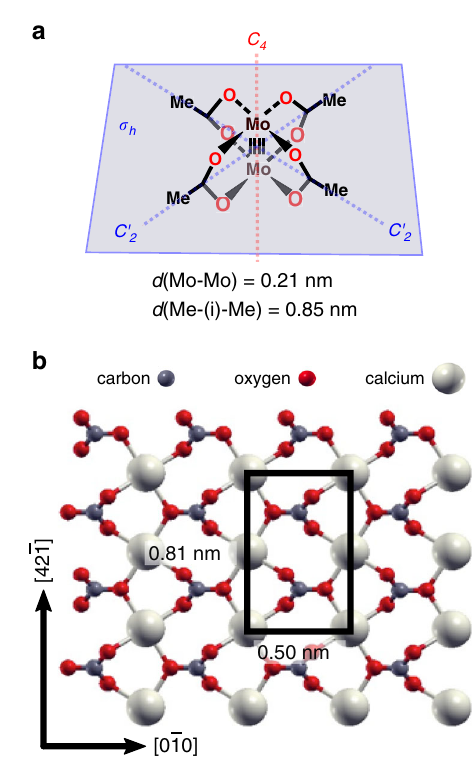
Fig. 1 Model of the system studied here. a The MoMo molecule adsorbed on b the calcite (10.4) surface. The surface unit cell is marked with a black